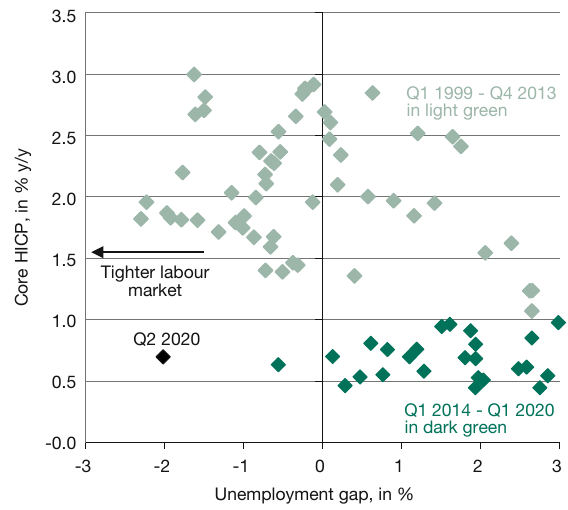
Spain: Phillips curve since 1999 using European Commission estimates for the unemployment gap